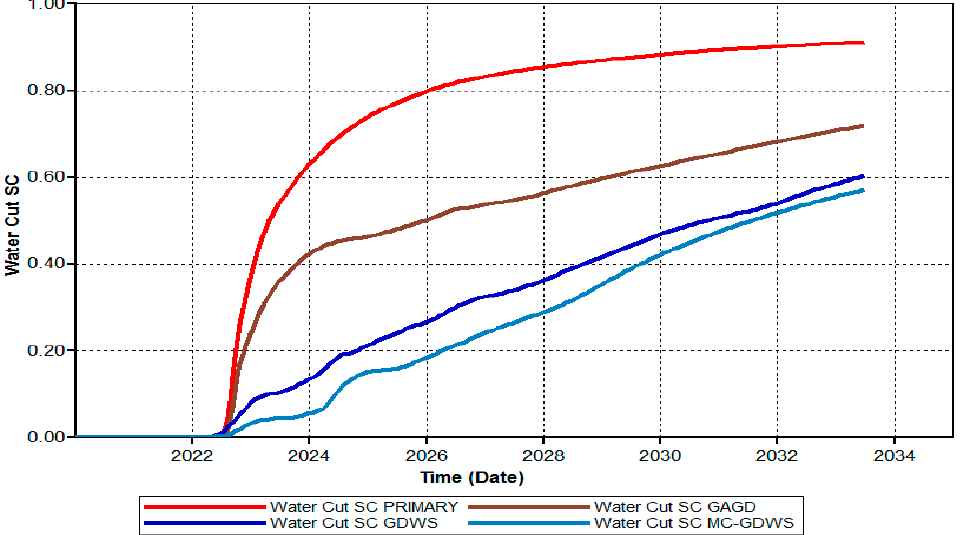
Figure 7. Water cut expressed by year in standard conditions for the TC-GDWS-AGD, GDWS-AGD, GAGD, and primary (base-case) PUNQ-S3